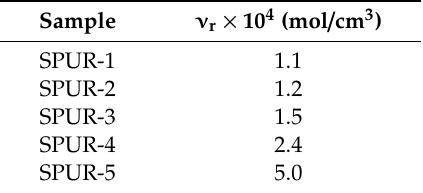
Table 5. The crosslink densities calculated by Equation (13). for the SPUR samples.